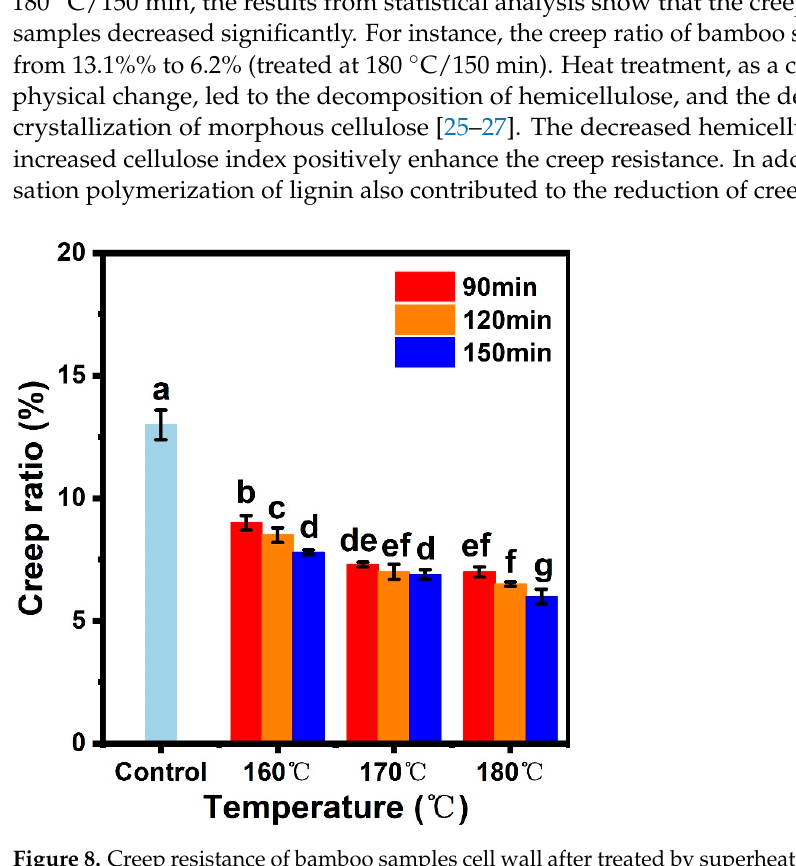
Figure 8. Creep resistance of bamboo samples cell wall after treated by superheated steam at different temperature and time. The different letters represent significant differences between treatments ( p < 0.05).